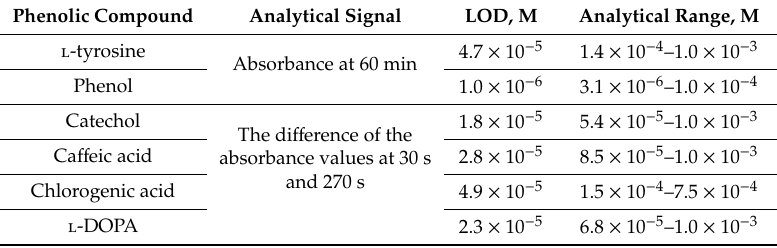
Table 5. Analytical parameters of phenolic compounds determination procedures using crude A. bisporus extract ( n = 3 for LOD).